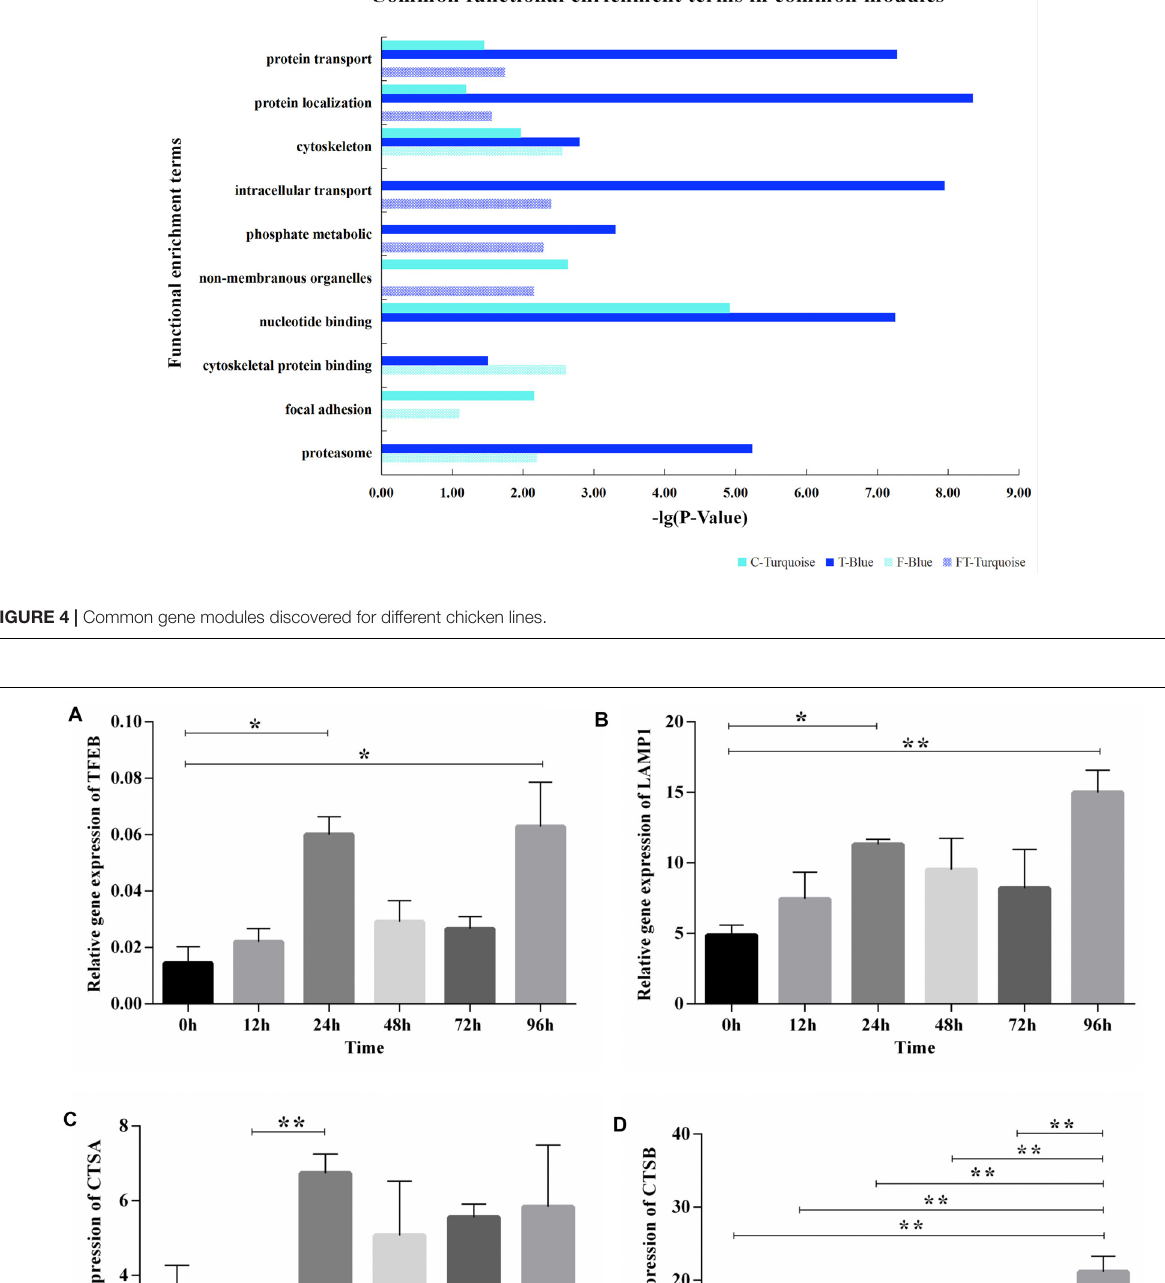
Frontiers in Genetics |